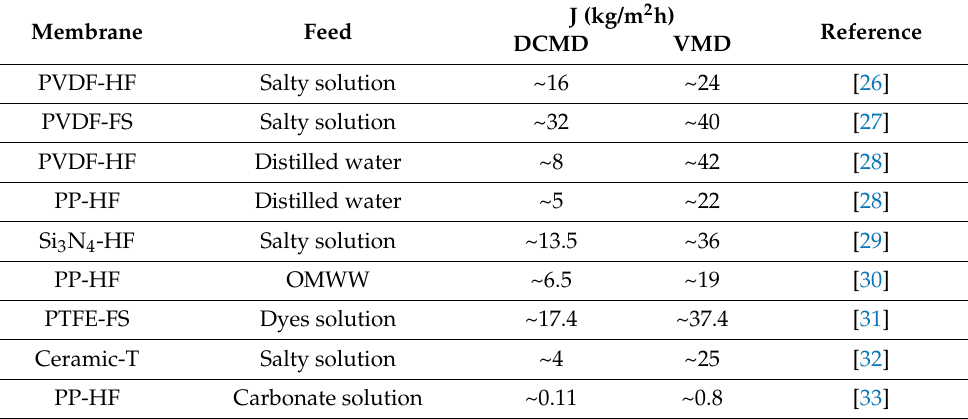
Table 1. Comparison between DCMD and VMD reported in the literature.